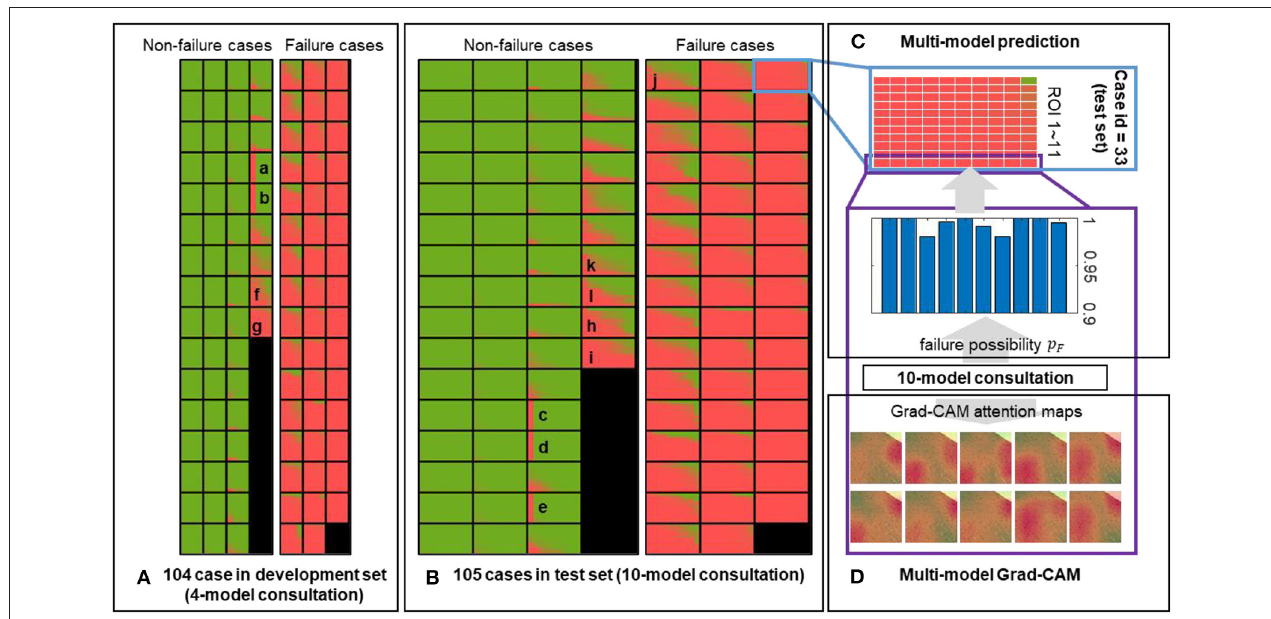
FIGURE 6 | Predictions of the multi-model ensemble. The failure probability predicted for each ROI of each case in the (A) development and (B) held-out test sets is mapped out. The low and high likelihood of being failure are represented in green and red, respectively. (C) An example case from the held-out test set is used to demonstrate the multi-model ensemble. Each block composed of 11 × 10 grids represents a single case, corresponding to the outputs from 10 sub-models applied on 11 ROIs. Each sub-model independently generates a prediction on each ROI, and all 11 × 10 outputs are ensembled to reflect the discrepancy among all sub-models. (D) Representative attention maps are generated by 10 sub-models independently on the same ROI, providing the failure probabilities and dominant morphology in the process of a comprehensive evaluation. Image size: 50 × 50 µ m 2